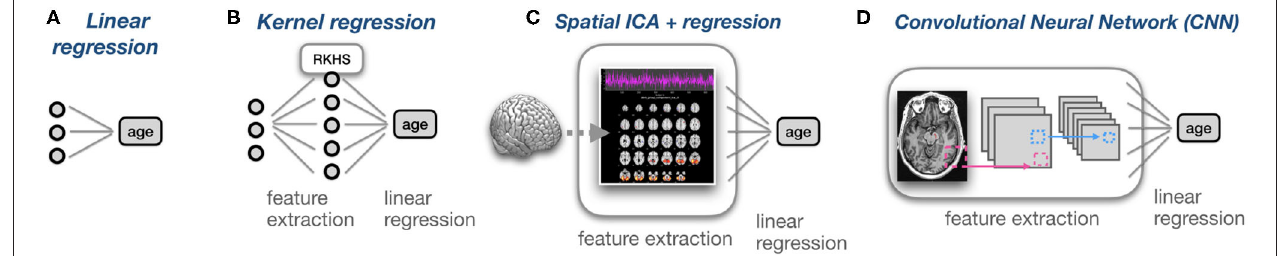
FIGURE 6 | Coupled with non-linear feature extraction techniques, linear regression becomes a powerful model that is implicitly a part of many regression models. (A) Linear regression using three features to predict age. (B) Kernel regression can be conceived of as a projection of the data into a higher-dimensional, Reproducing Kernel Hilbert Space (RKHS), followed by linear regression in this space. (C) MRIs can be transformed into components using ICA. For each MRI, its loadings on the different Independent Components can be used as features for linear regression. (D) In Convolutional Neural Networks (CNN) for regression, the last layer is typically linear. The preceding layers can be conceived of as feature extraction layers, and the last layer performs linear regression on non-linear features.